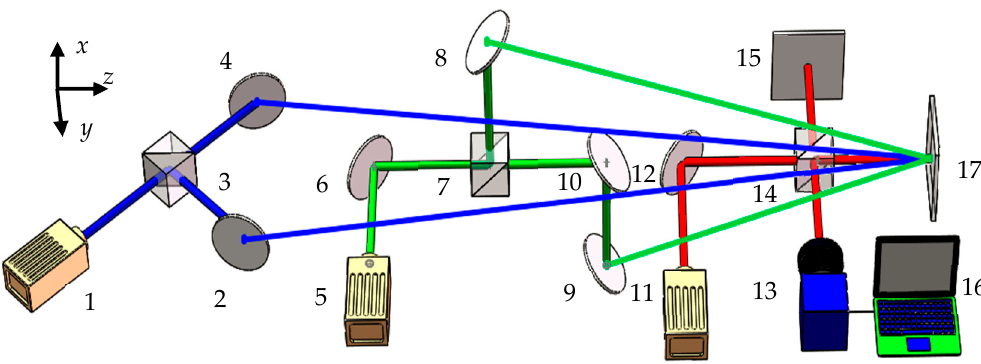
Figure 3. Principle of three-dimensional measurement: 1, 5, and 11 are lasers; 2, 4, 6, 8–10, and 12 are reflectors; 3, 7, and 14 are beam splitters; 13 is the color CCD camera; 15 is reference; 16 is computer; and 17 is object.